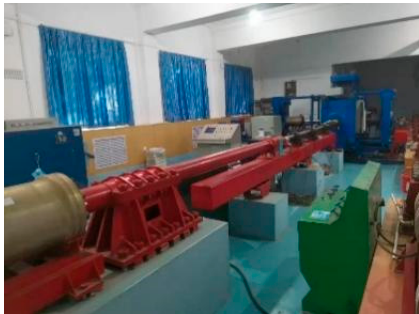
Figure 2. Triaxial static-dynamic comprehensive loading test system.